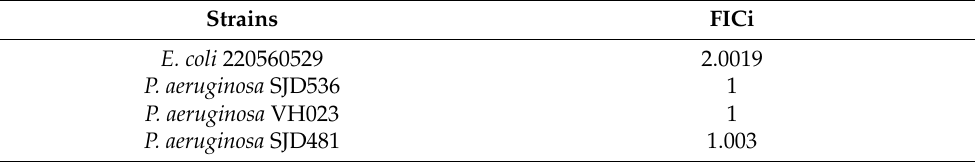
Table 3. Fractional inhibitory concentration index (FICi) of TMP-SMX (1:20) with colistin. Strains